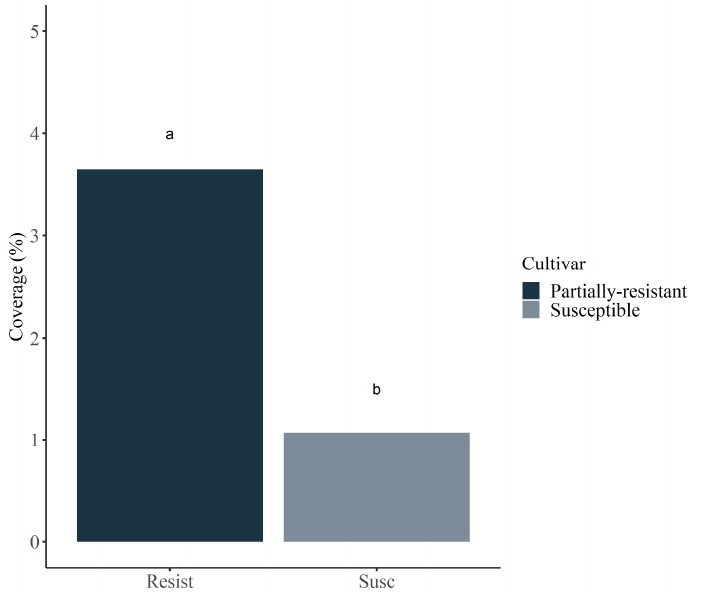
Figure 12. Mean percentage of coverage (%) in water-sensitive papers that were located at the lower region of the soybean canopy, according to different soybean cultivars in the second application of Field 1. The means followed by the same letter did not differ by the Tukey’s test at 5% probability ( p < 0.05).